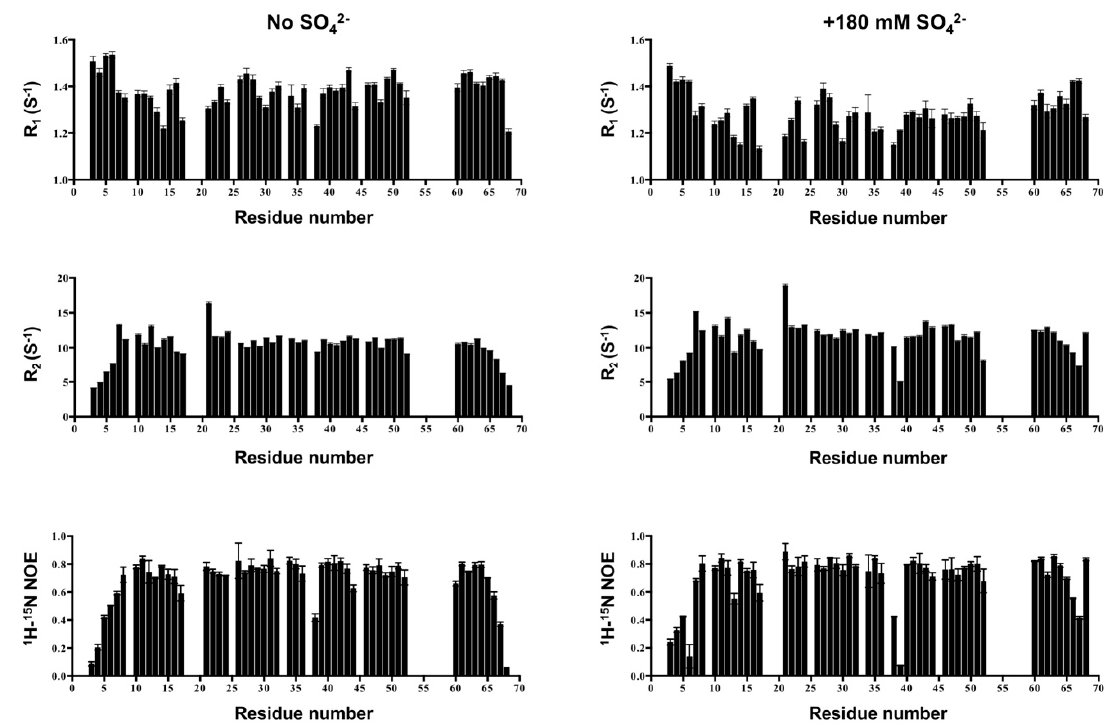
Figure 6. Backbone relaxation data of CCL5- 12 AAA 14 in the absence or presence of 180 mM ammonium sulfate. 15 N-R 1 , R 2 and 1 H- 15 N NOE (from top to bottom) were obtained for all non-proline residues except for the missing residues (M0, S1, L19, K25, K33, K45, E54, K55, K56, W57, V58, and R59). Table 2. NMR dynamic parameters of CCL5s.